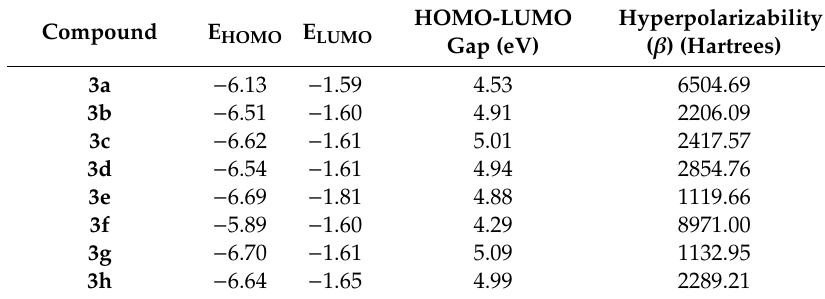
Table 2. Energies of HOMO (Highest occupied molecular orbital), LUMO (Lowest unoccupied molecular orbital), the gap between HOMO and LUMO and hyperpolarizability ( β ) values. HOMO-LUMO Hyperpolarizability Compound E HOMO E LUMO Gap (eV) ( β ) (Hartrees) 3a − 6.13 − 1.59 4.53 6504.69 3b − 6.51 − 1.60 4.91 2206.09 3c − 6.62 − 1.61 5.01 2417.57 2854.76 1119.66